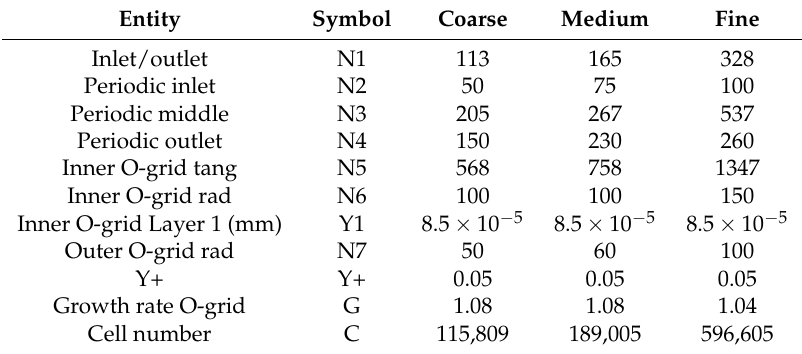
Table 3. Features of the mesh.